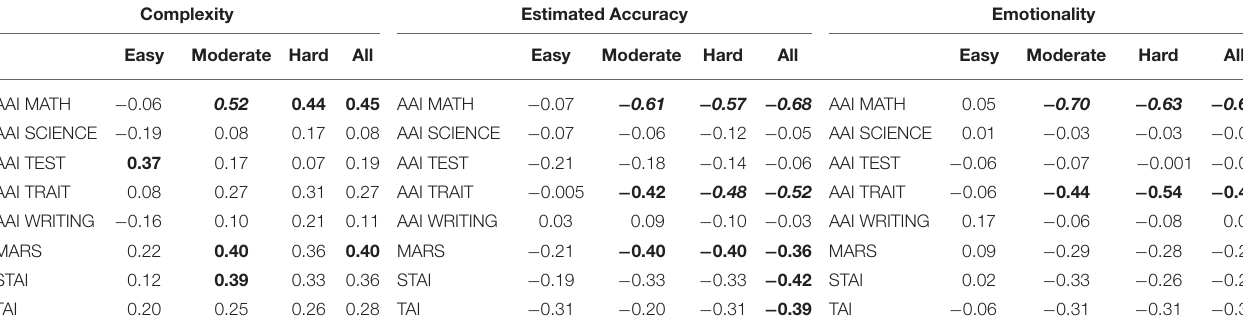
TABLE 8 | Correlations between anxiety measures and ratings of mathematical expressions in Study 4 ( N = 33). Complexity Estimated Accuracy Emotionality Easy Moderate Hard All Easy Moderate Hard All Easy Moderate Hard